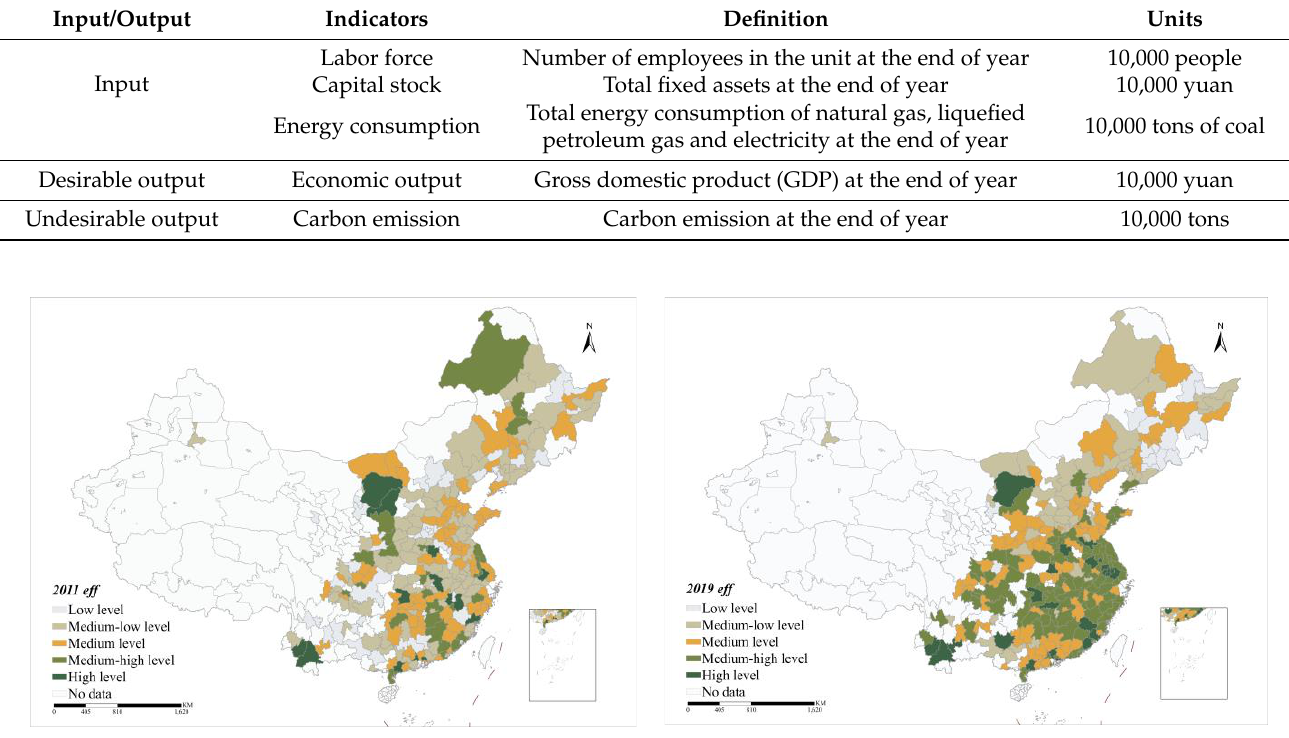
Table 1. Evaluation system of carbon emission efficiency.